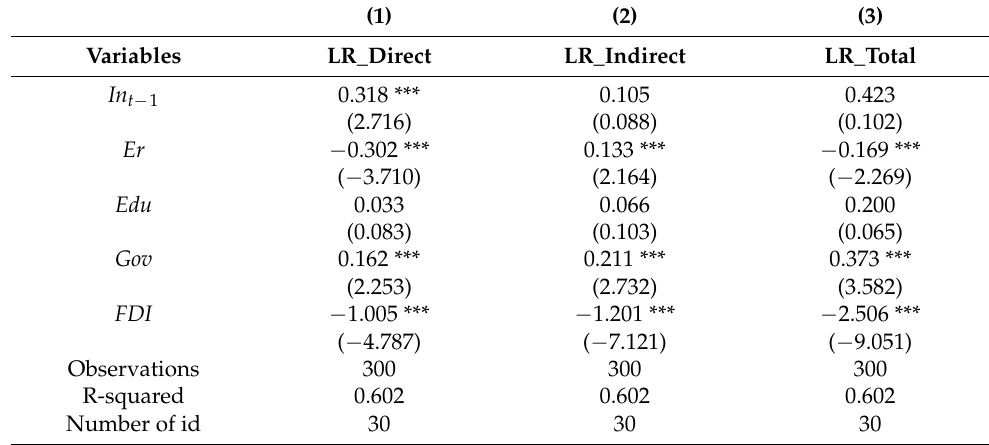
Table 9. Robustness test results for environmental regulation and